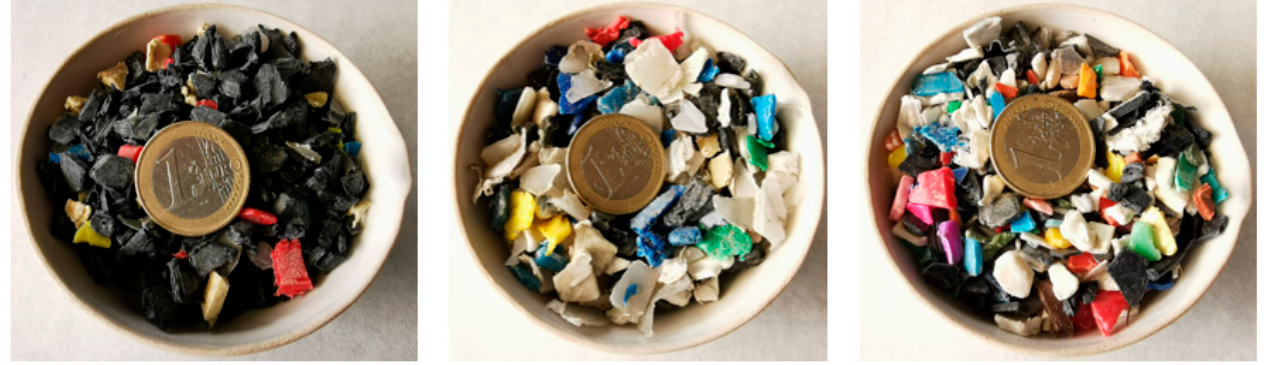
Figure 1. Plastic waste. From left to right: PLA-1, PLA-2 and PLA-3.